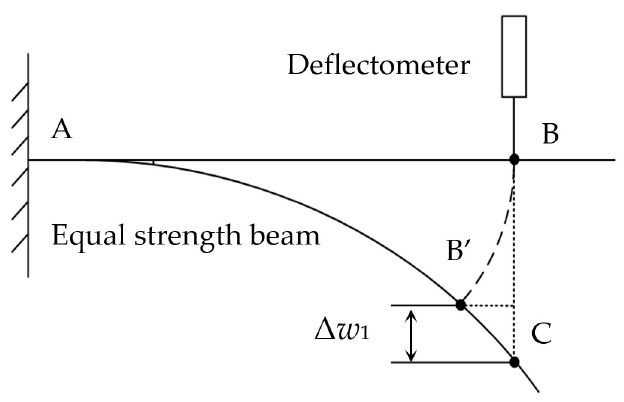
axial displacement, caused by the beam bending, will change the measurement position of the deflection. As shown in Figure 6, the deflection measurement position changes from point B to C after the beam was bent. If the change of deflection measuring position is not taken into account during strain calculation, a deflection measurement error of ∆ w 1 will be introduced, and make the calculated strain value larger. The corresponding error was called the measurement position offset error and was denoted as + ∆ ε p .